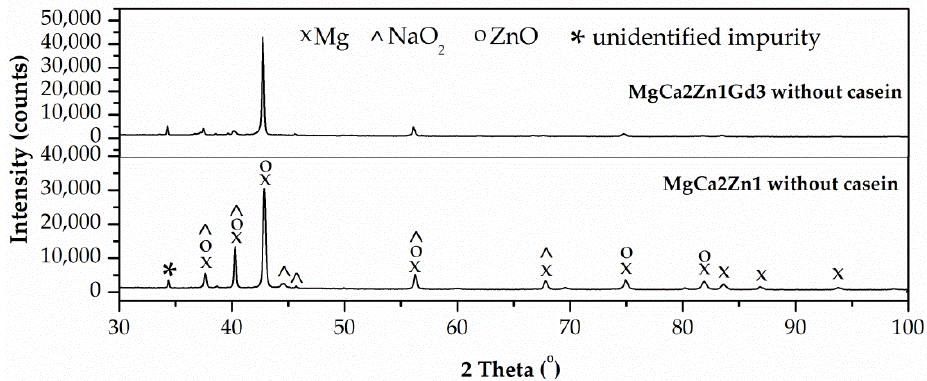
Figure 5. X-ray diffraction patterns of the casein-free conversion coating applied onto MgCa2Zn1 and MgCa2Zn1Gd3 alloys.